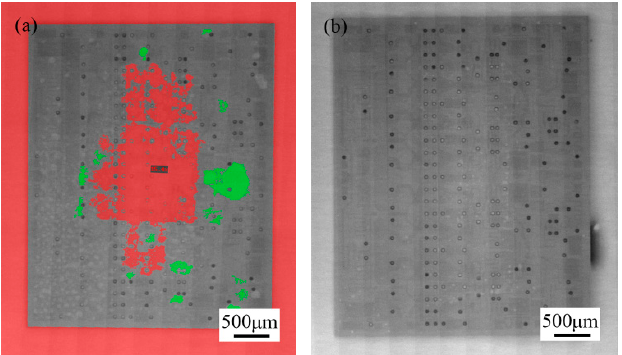
Figure 11. Void content of the Au/Ti/Au|Au-Sn eutectic joint: ( a ) 18.54% and ( b ) 2.36%.